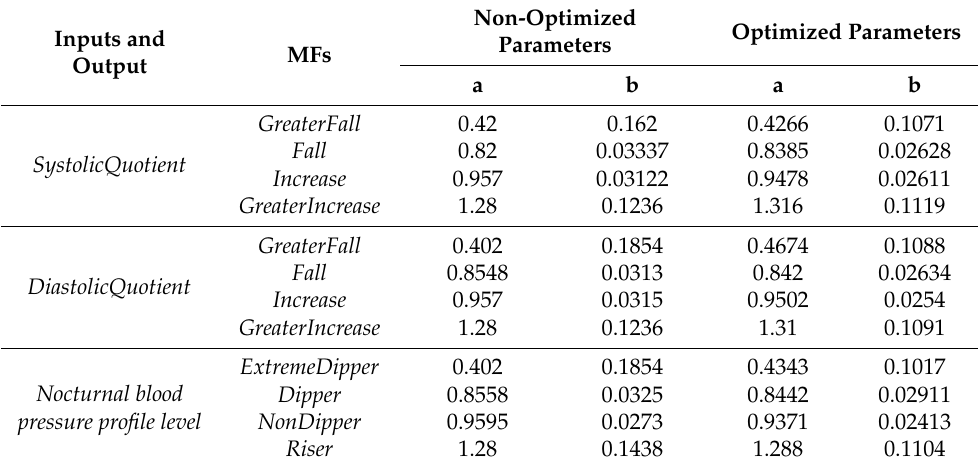
Table 12. Parameters used for the nocturnal blood pressure classifier design with Gaussian member- ship